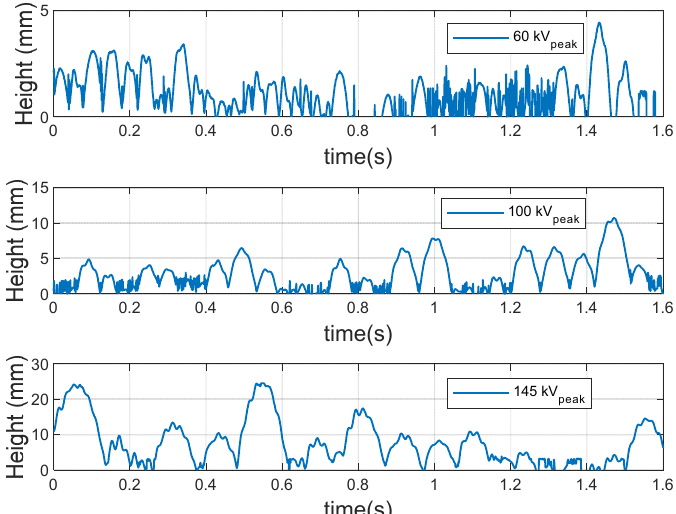
Figure 6. Vertical particle trajectories for a particle with 4 mm length and 0.9 mm diameter in 0.75 MPa CO 2 /O 2 , determined from video images for 60, 100, and 145 kV peak applied voltage. The noise results from uncertainties of the particle tracking procedure at small amplitudes. The uncertainty of the determined heights was estimated to be about 2 mm.